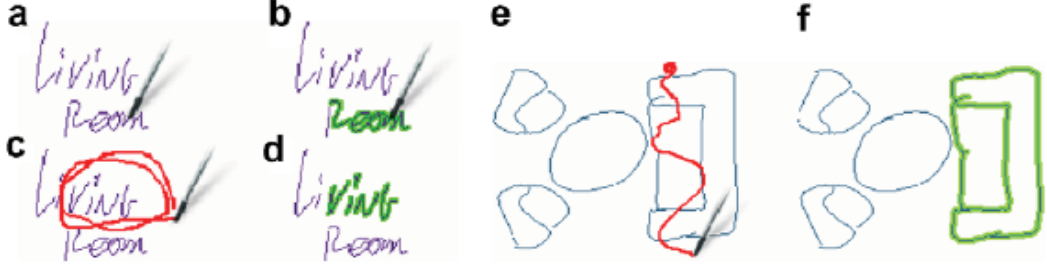
Figure 3. ( a ) After creating a sketch, holding the stylus on a stroke (‘‘room’’ work on